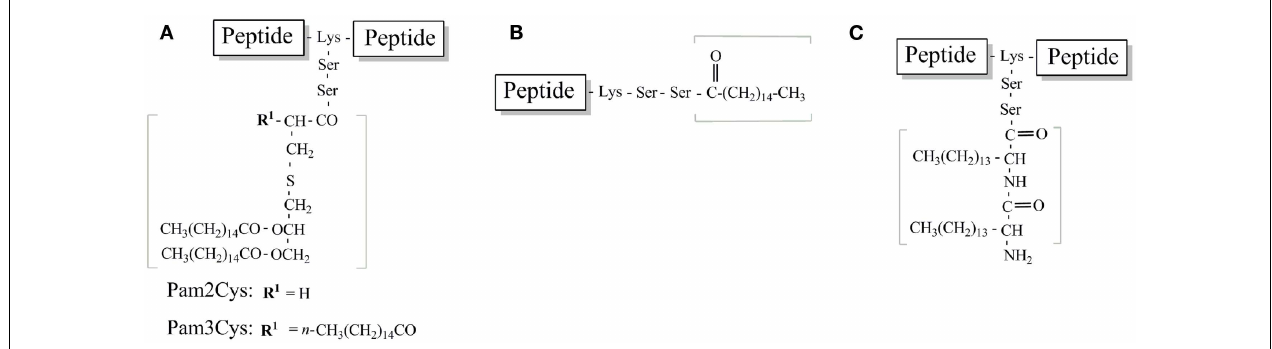
FIGURE 5 | Schematic structure ofTLR2-targeting lipopeptides used in peptide vaccine development . (A) Pam2Cys and Pam3Cys lipidated peptide. (B) Palmitoylated peptide (C) . Lipoamino acid-based peptide.